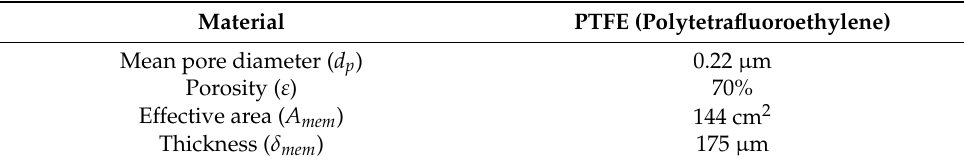
Figure 3. Experimental membrane desorber/condenser unit [25]. The characteristics of the hydrophobic membrane are shown in Table 1. Table 1. Membrane